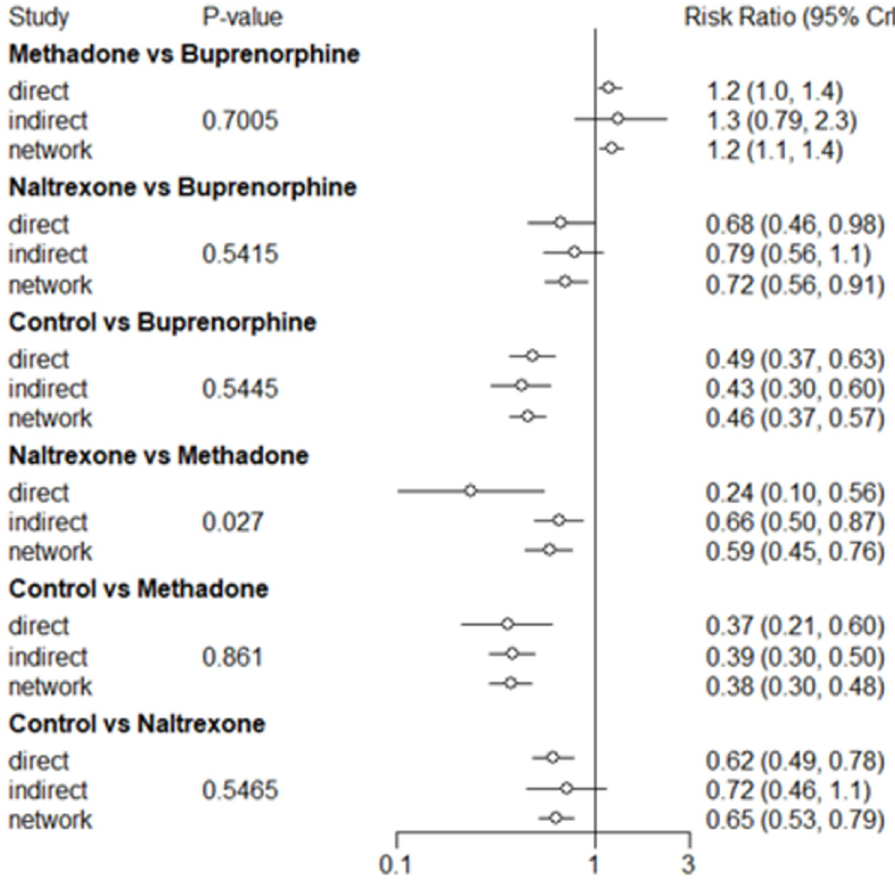
Fig 4. Direct and indirect estimate of the likelihood of retention between treatments using the node-splitting method to assess consistency of the network model.